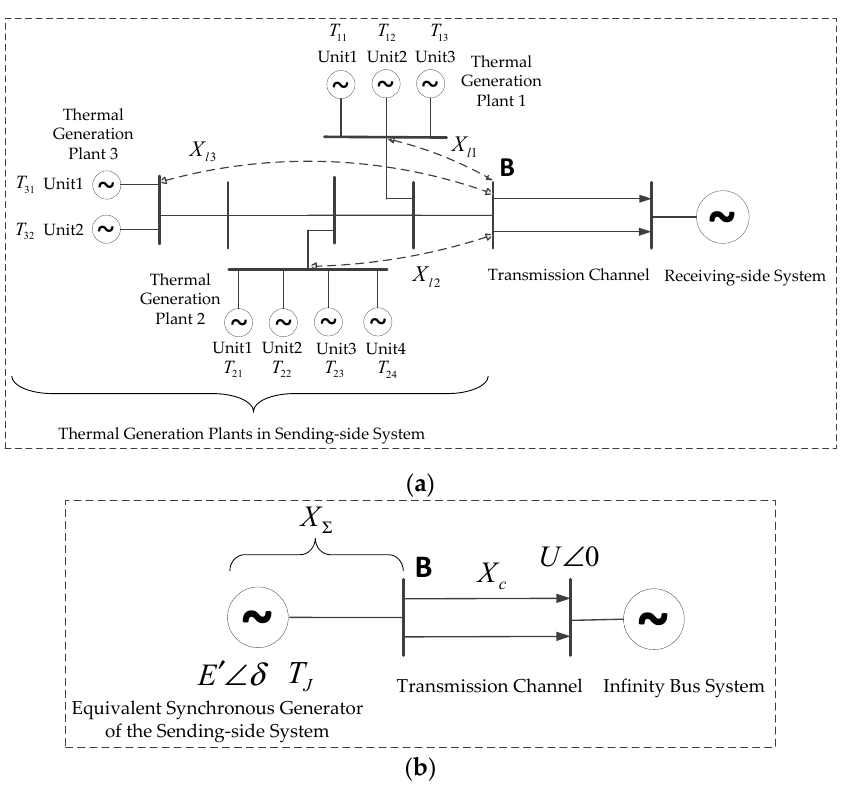
Figure 3. ( a ) Diagram of a multi-generator sending-side system and receiving-side system and transmission channel; ( b ) diagram of an equivalent sending-side system and receiving-side system and transmission channel.